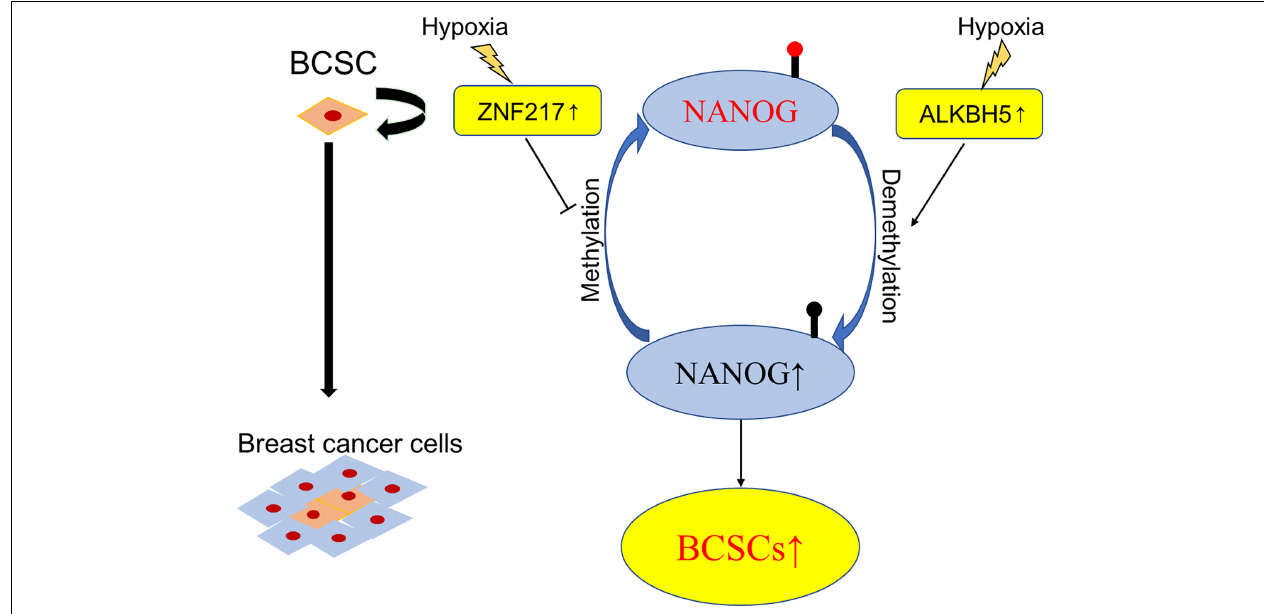
FIGURE 3 | Schematic elucidation of m6A in BCSCs. Exposure of breast cancer cells to hypoxia can induce ALKBH5-mediated demethylation of NANOG mRNA, leading to increased expression of NANOG, and increasing the percentage of BCSCs.